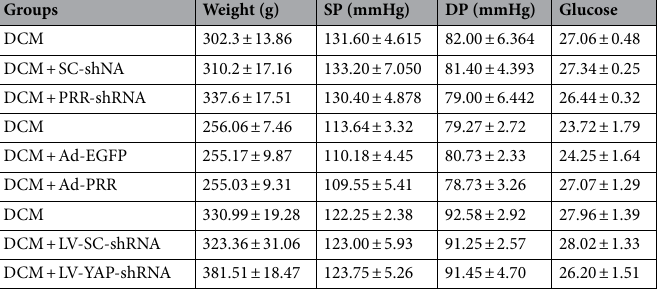
Table 1. Body weight, blood pressure, and blood glucose in three separate experiments in rats.